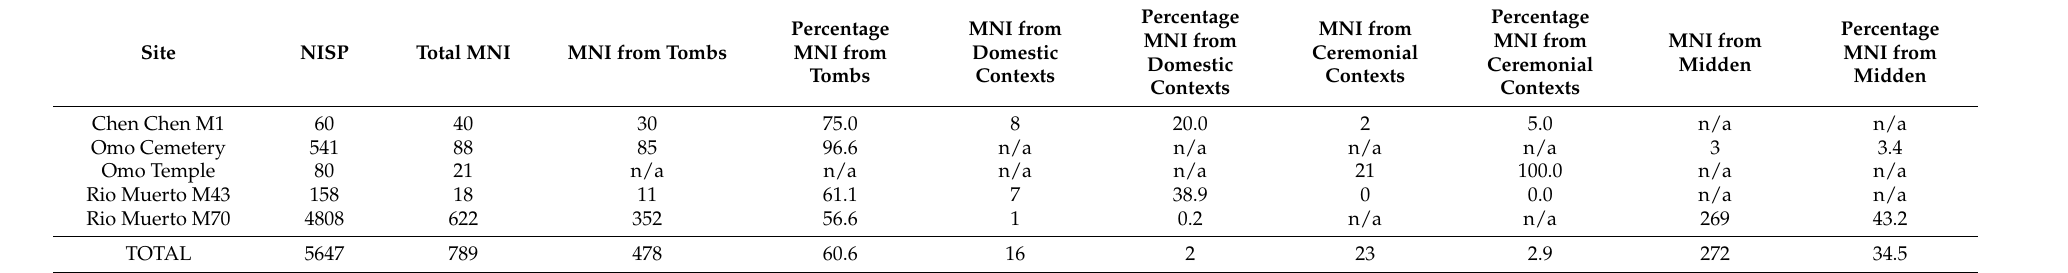
Table 1. Anura NISP and MNI by site and context